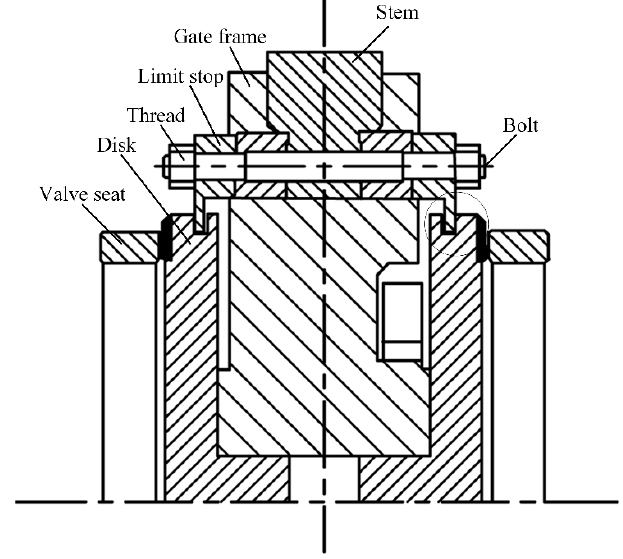
Figure 2. The structure of the disk component.